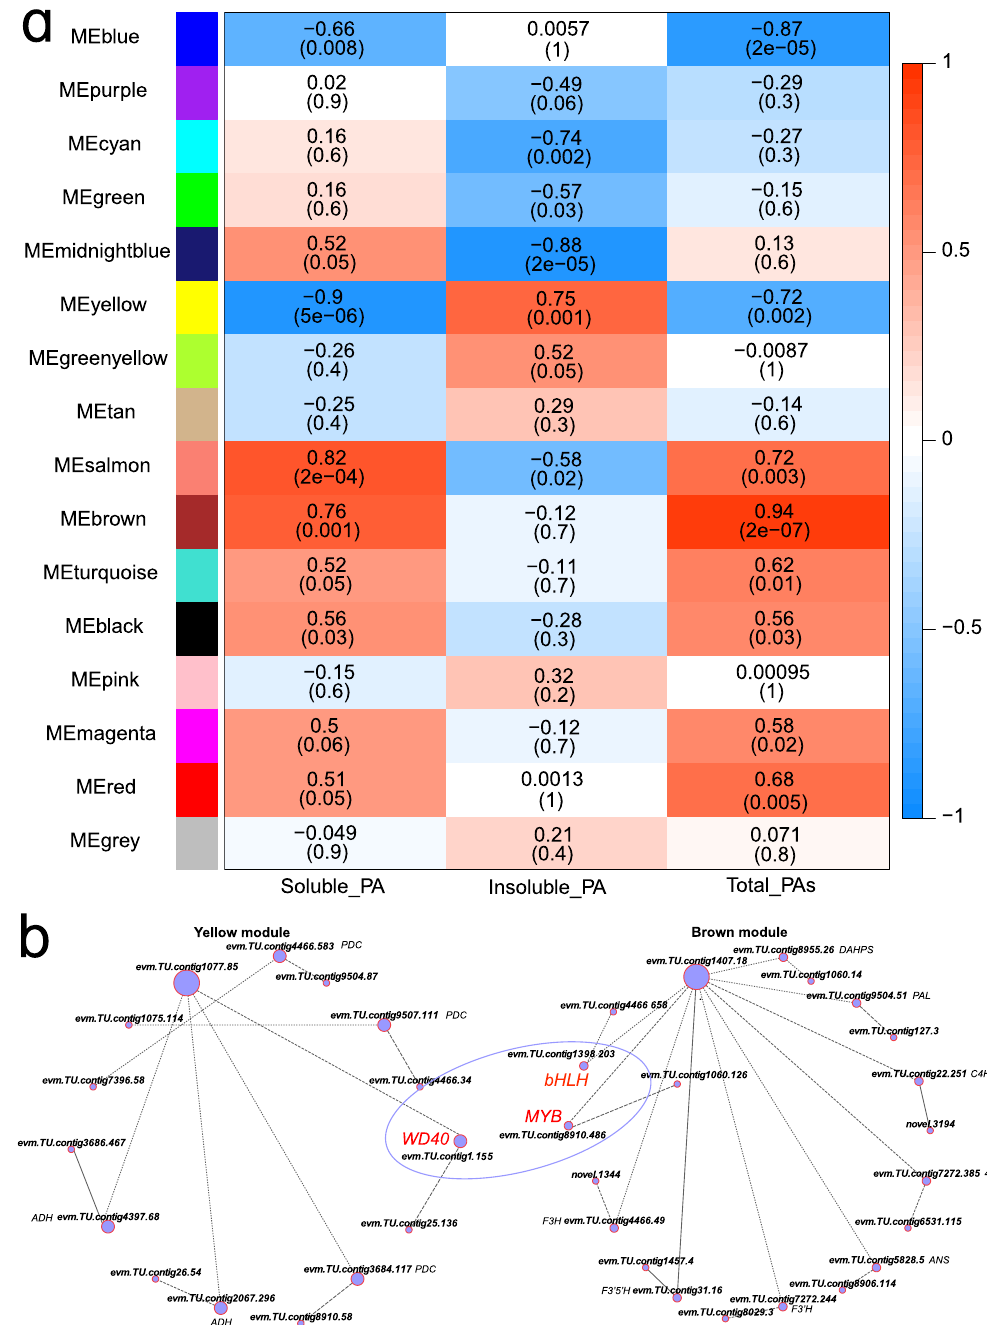
Figure 6. Weighted gene coexpression network analysis. ( a ) Gene modules defined using WGCNA and the association with soluble PA, insoluble PA, and total PA content. The numbers in the heatmap show the P -value (lower) and the correlation (upper). ( b ) The linkages of PA biosynthesis and insolubilization DEGs in yellow and brown modules, and the circles are sized by the gene